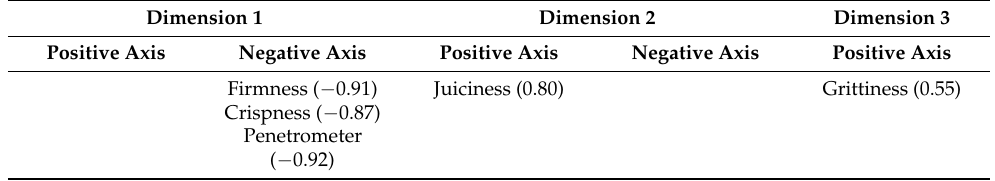
Figure 1. The consensus space of the first and the second dimension after GPA for all 80 pear genotypes: ( a ) relationship between texture sensory data (firmness, crispness, juiciness, and grittiness) and instrumental data (penetrometer); ( b ) relationship between flavour sensory data (sweetness, sourness, and astringency) and instrumental data (TSS, TA, and TSS/TA ratio). Table 4. Correlation coefficient ( r > 0.5) between the texture descriptors and the first three